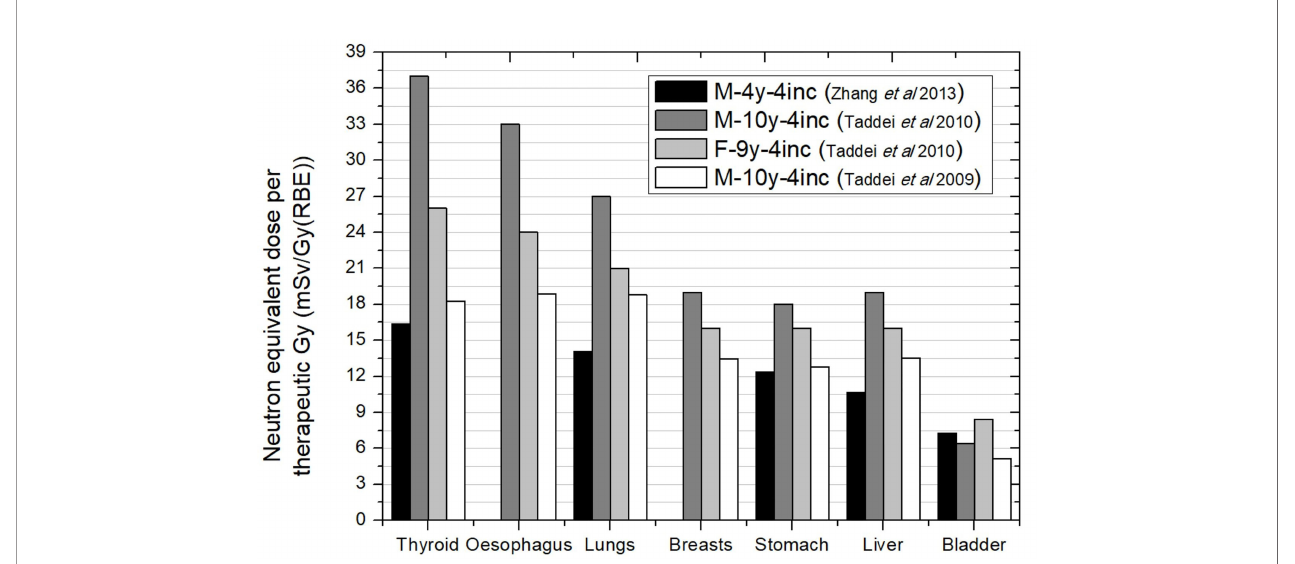
FIGURE 7 | Neutron equivalent doses per therapeutic Gy in selected organs for CSI without boost for different passive scattering proton beam facility facilities. Data extracted from Taddei et al. (2009), (2010) (40, 42) and Zhang et al. (43). In the legend, the sex (F, female; M, male), age of the patient (#y = number of years) and number of incidences (#inc = number of incidences) are speci fi ed.